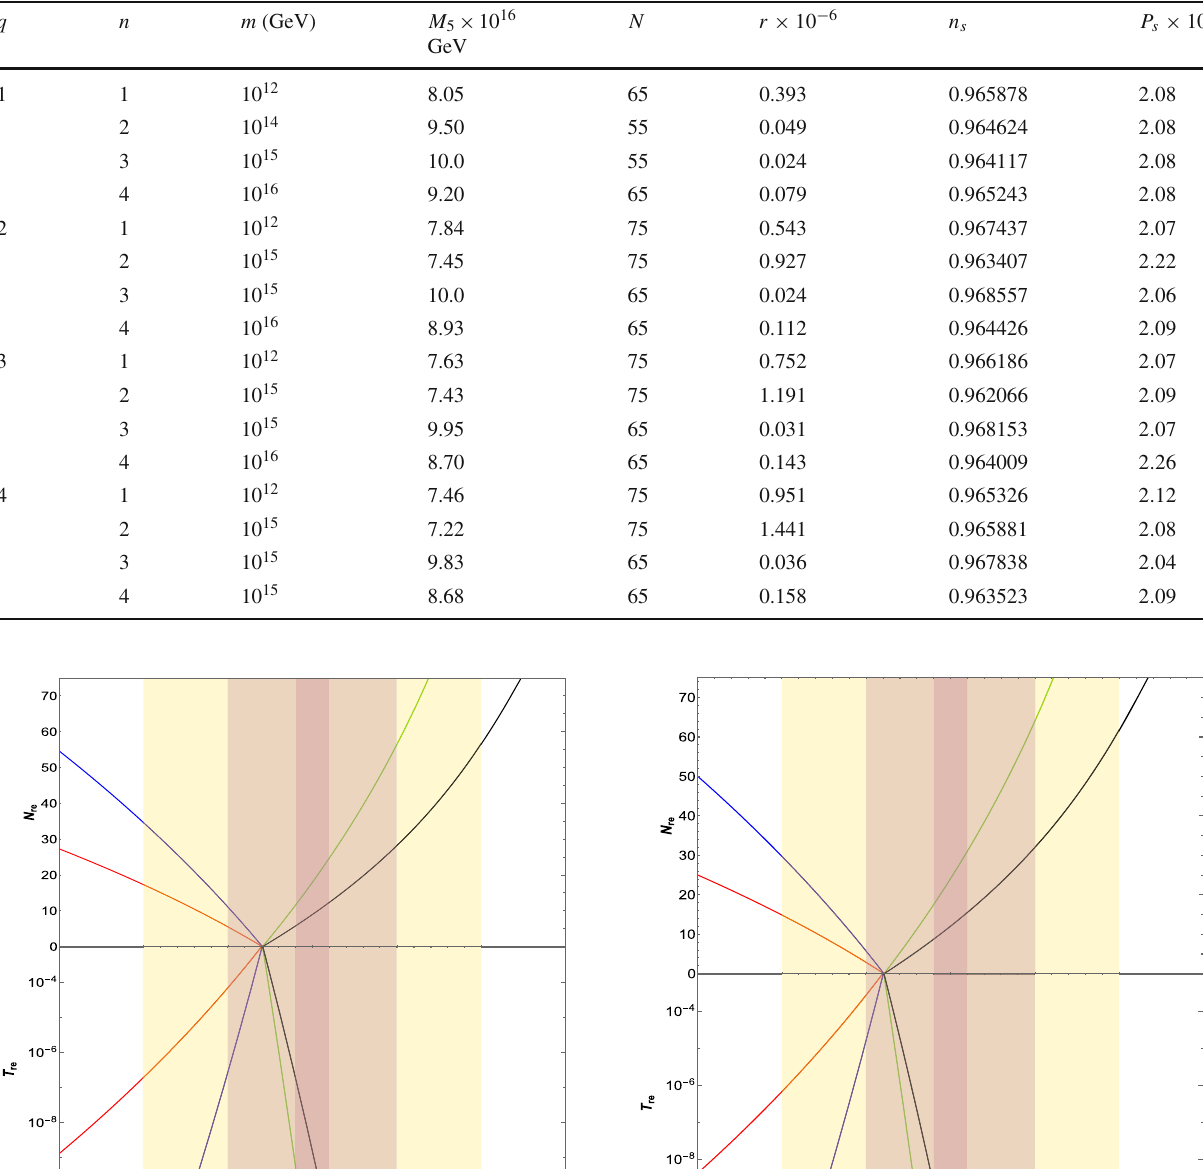
Table 1 Values of different cosmological observables for the different combination of n , q , n , m , N and M 5